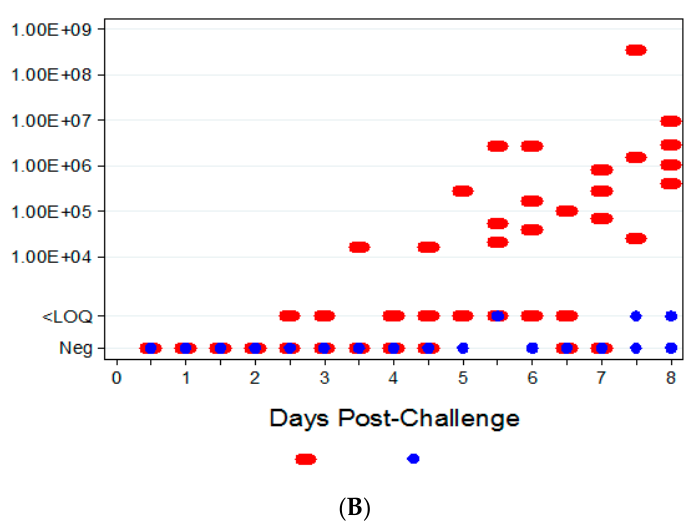
Figure 6. Animal qPCR titers in tissue. ( A ) qPCR titers in the spleen following ECTV ‐ Mos infection. Quantifiable viral titers were first measured at 3.5 days and increased as time progressed, with the highest titers present at seven to eight days following challenge; ( B ) qPCR titers in the liver following ECTV ‐ Mos infection. Viral titers were first measured at 3.5 days PI and slightly increased over time, with the highest titers observed between 7.5 and 8 days following challenge.